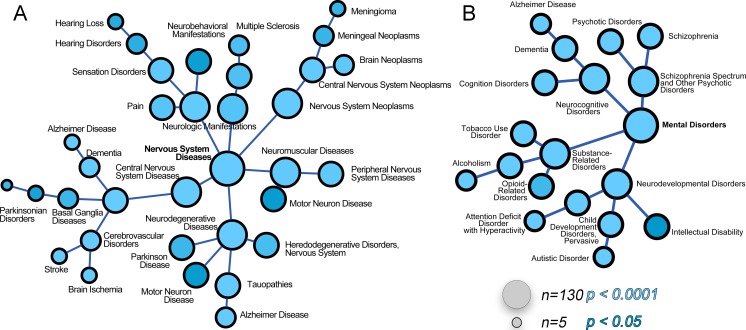
The ATP7A interactome enriches gene products associated with nervous system diseases and mental disorders.(A–B) The ATP7A interactome was analyzed using the GDA bioinformatics tool, which derives disease-gene links from human databases OMIM and Genopedia. Nervous system diseases (A) and mental disorders (B) were both significantly enriched in the dataset (p<0.0001). Circle size represents number of gene product from the ATP7A interactome in the disease category. Shades of blue depict p values.